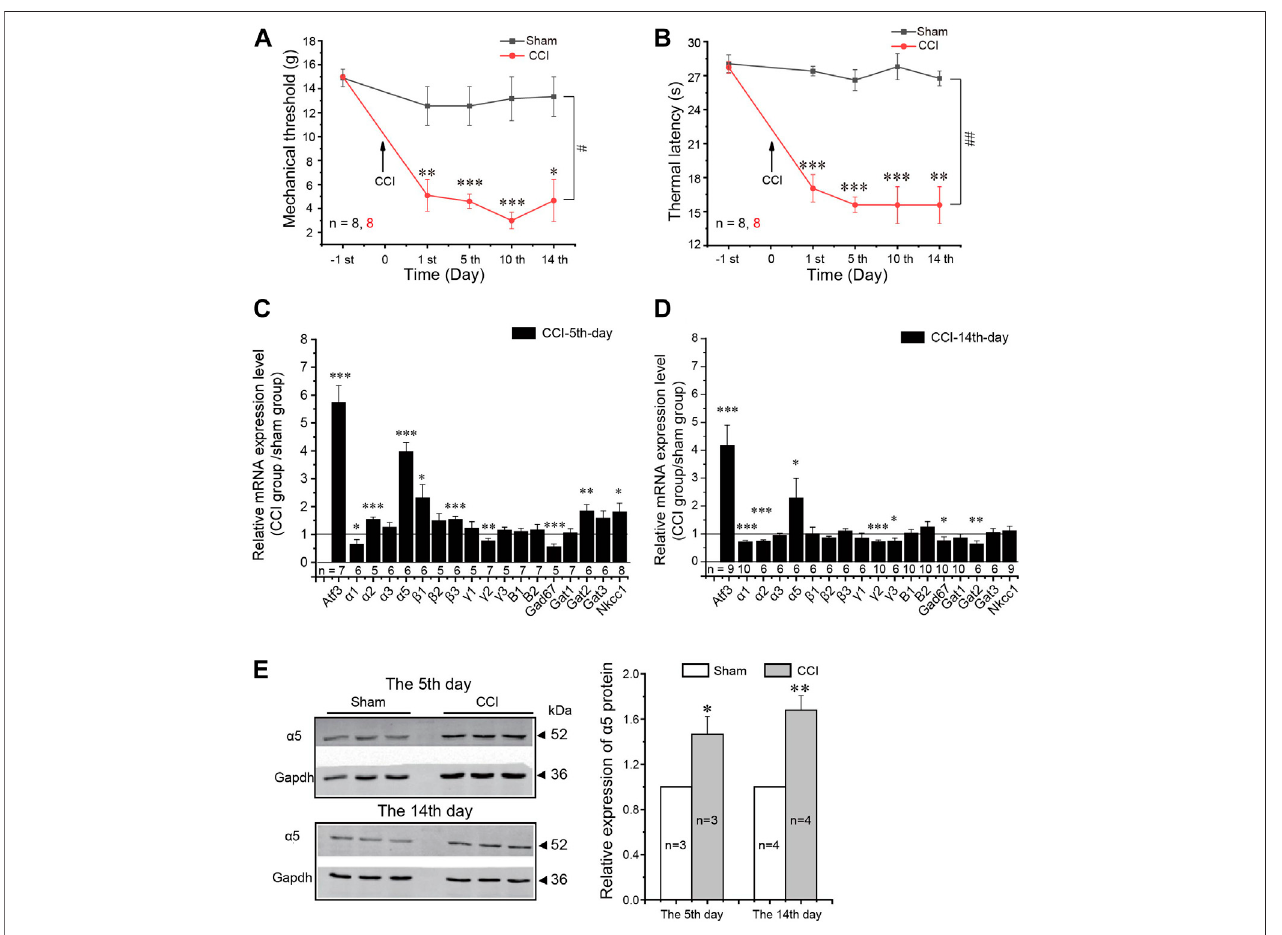
FIGURE 3 | Expression of GABA-related components in the DRG induced by neuropathic pain. (A,B) Mechanical threshold (A) and thermal latency (B) were signi fi cantlyreducedduringthetwoweeksafterCCIsurgeryinrats.RepeatedmeasuresANOVAwiththeBonferronicorrectionwasusedforcomparisonofhyperalgesia measurements between the sham and CCI groups: # p < 0.05, ## p < 0.01; one-way ANOVA was used for comparison within the corresponding time point: * p < 0.05. (C,D) mRNArelativeexpressionlevelofindicatedGABA-relatedcomponentsintheL4 – 6DRGsofratsonthe5th (C) and14th (D) daysafterCCIsurgerycompared with the sham group. GAPDH was used as the internal reference for the mRNA expression level. One-way ANOVA with the Dunnett post hoc test was used for comparison between the tested group and the sham group: * p < 0.05, ** p < 0.01, *** p < 0.001. (E) Western blot analysis of the α 5 subunit of the GABA A receptor in the L4 – 6 DRGs of rats on the 5th and 14th days after CCI surgery (left, the representative results; right, summary of the changes in the α 5 protein level). * p < 0.05, ** p < 0.01(unpaired t -test). Number of experiments is indicated as n in each panel.